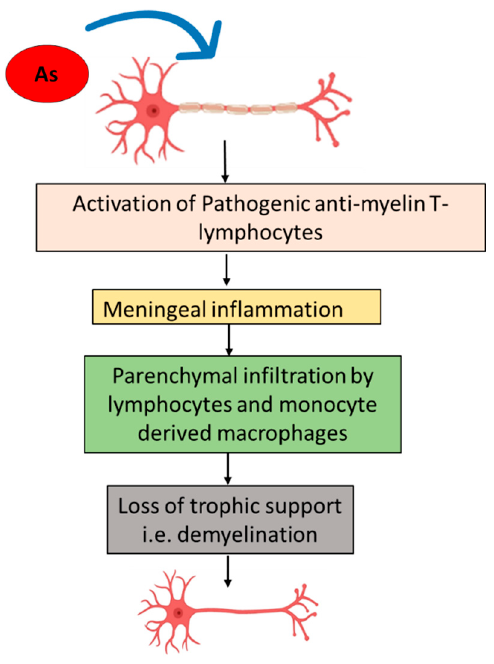
Figure 3. Demyelination upon arsenic (As) exposure through activation of pathogenic antimyelin T-lymphocytes leading to meningeal inflammation and parenchymal infiltration by lymphocyte and monocyte derived macrophages resulting in the loss of trophic support to the neurons.